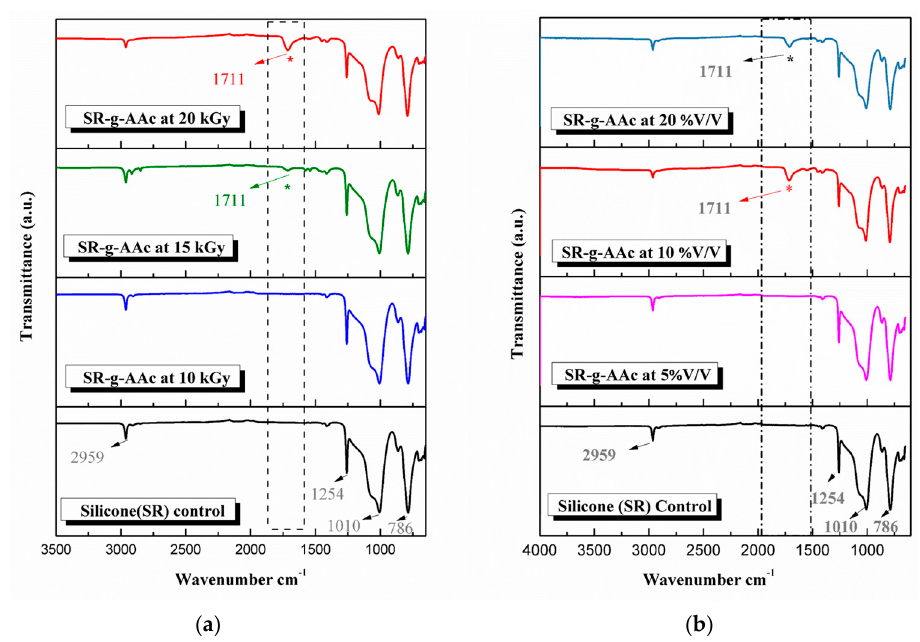
Figure 3. Fourier-transform infrared spectra (FTIR) of silicone segments before and after grafting with acrylic acid: ( a ) FTIR of pristine untreated silicone (SR) and silicone exposed to different gamma irradiation doses (10, 15, 20 kGy) at constant AAc monomer concentration (10% v / v ). ( b ) FTIR of SR and silicone gamma irradiated at 20 kGy using different AAc monomer concentrations (5, 10, 20% v / v ). * The appearance of an additional peak at 1711 cm − 1 corresponded to the stretching vibration of the carbonyl group (C=O), indicating the successful grafting of PAAc onto the surface of